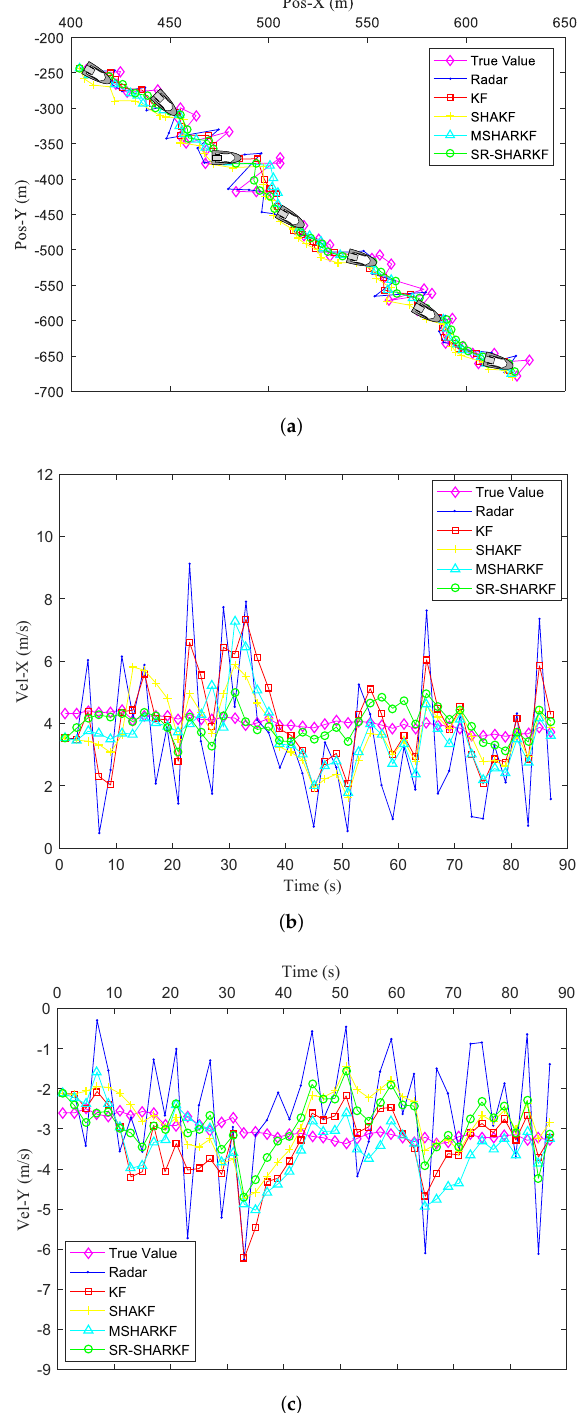
Figure 14. Filtering effect comparison of multiple algorithms in terms of position and velocity. ( a ) Target trajectory comparison. ( b ) Target velocity comparison in the X-axis direction. ( c ) Target velocity comparison in the Y-axis